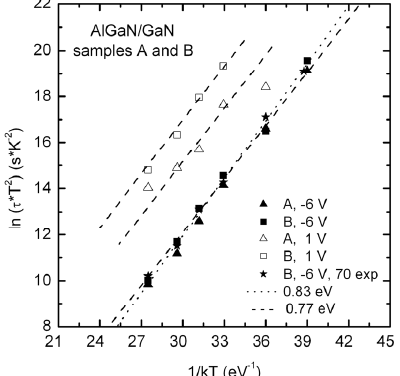
Figure 6. Arrhenius plot of the time constant for AlGaN/GaN SDs (Samples A and B) measured at reverse bias − 6 V (full marks) and forward bias +1 V (open marks). For comparison, data obtained by fitting with 80 exponentials are also shown (full stars). Dashed lines correspond to the energy of 0.77 and 0.83 eV.